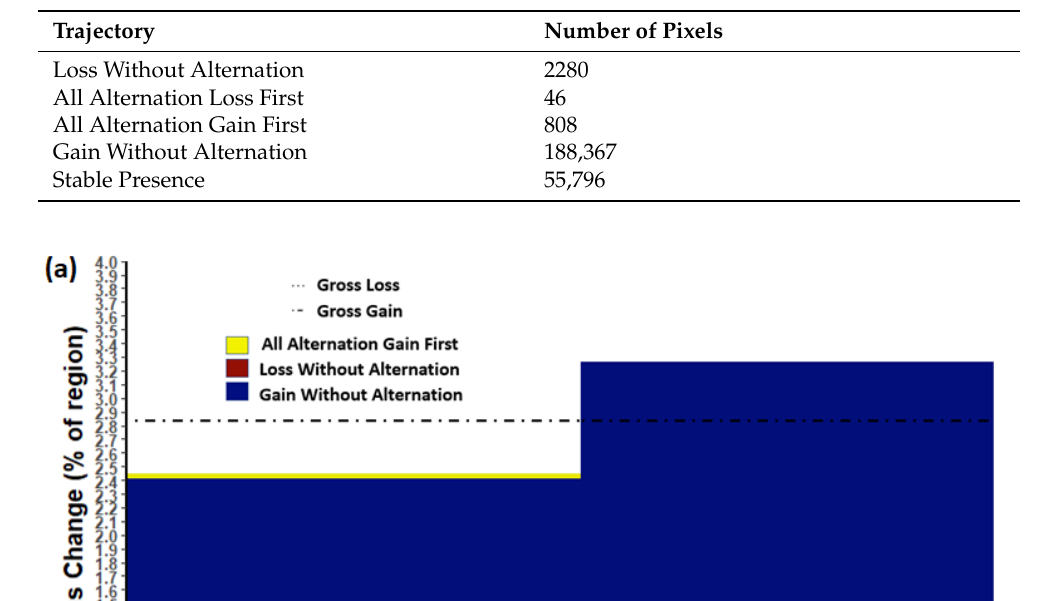
Table 4. Sizes of trajectories that constitute the unified region in Kumasi.